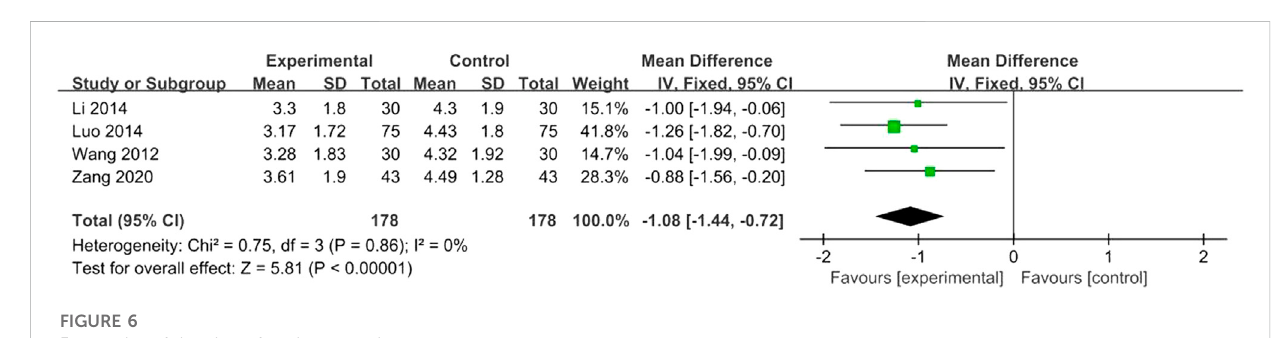
FIGURE 6 Forest plot of duration of angina